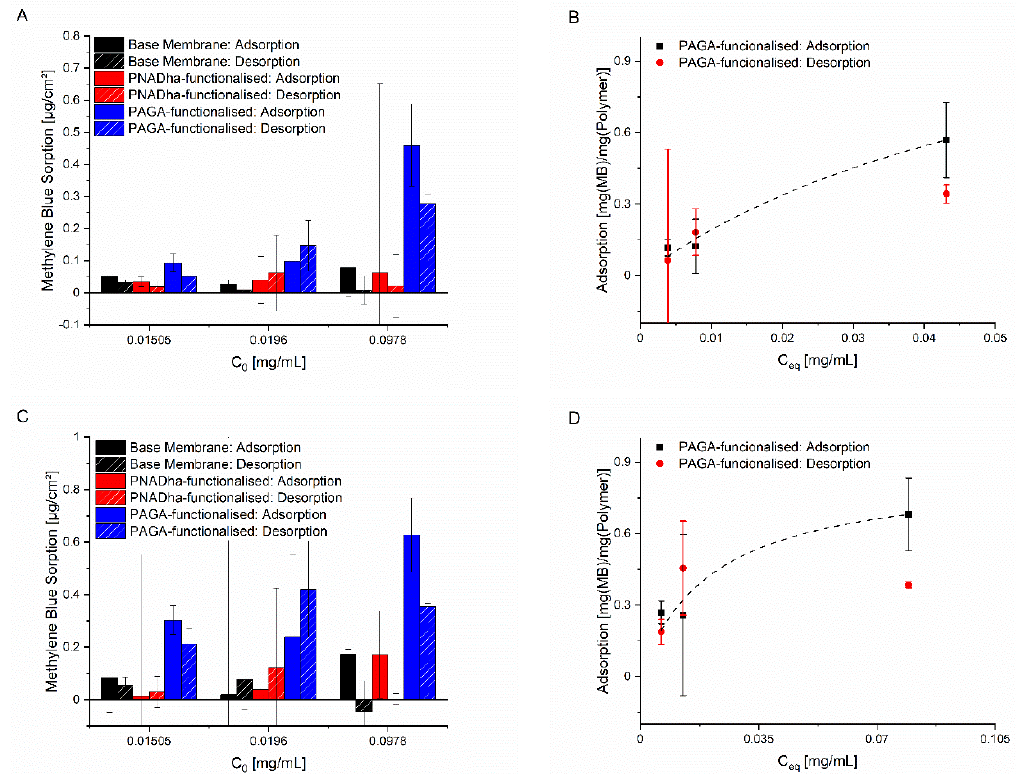
Figure 5. Adsorption of methylene blue on (functionalised) track etched membranes: ( A ) Bar chart summarising the results for the membranes with an average pore size of 0.2 µ m; ( B ) Adsorption isotherm for methylene blue onto PAGA functionalised membranes with a nominal pore size of 0.2 µ m and fitted Langmuir isotherm; ( C ) Bar chart summarising the results for the membranes with an average pore size of 1 µ m; ( D ) Adsorption isotherm for methylene blue onto PAGA functionalised membranes with a nominal pore size of 1 µ m and fitted Langmuir isotherm.